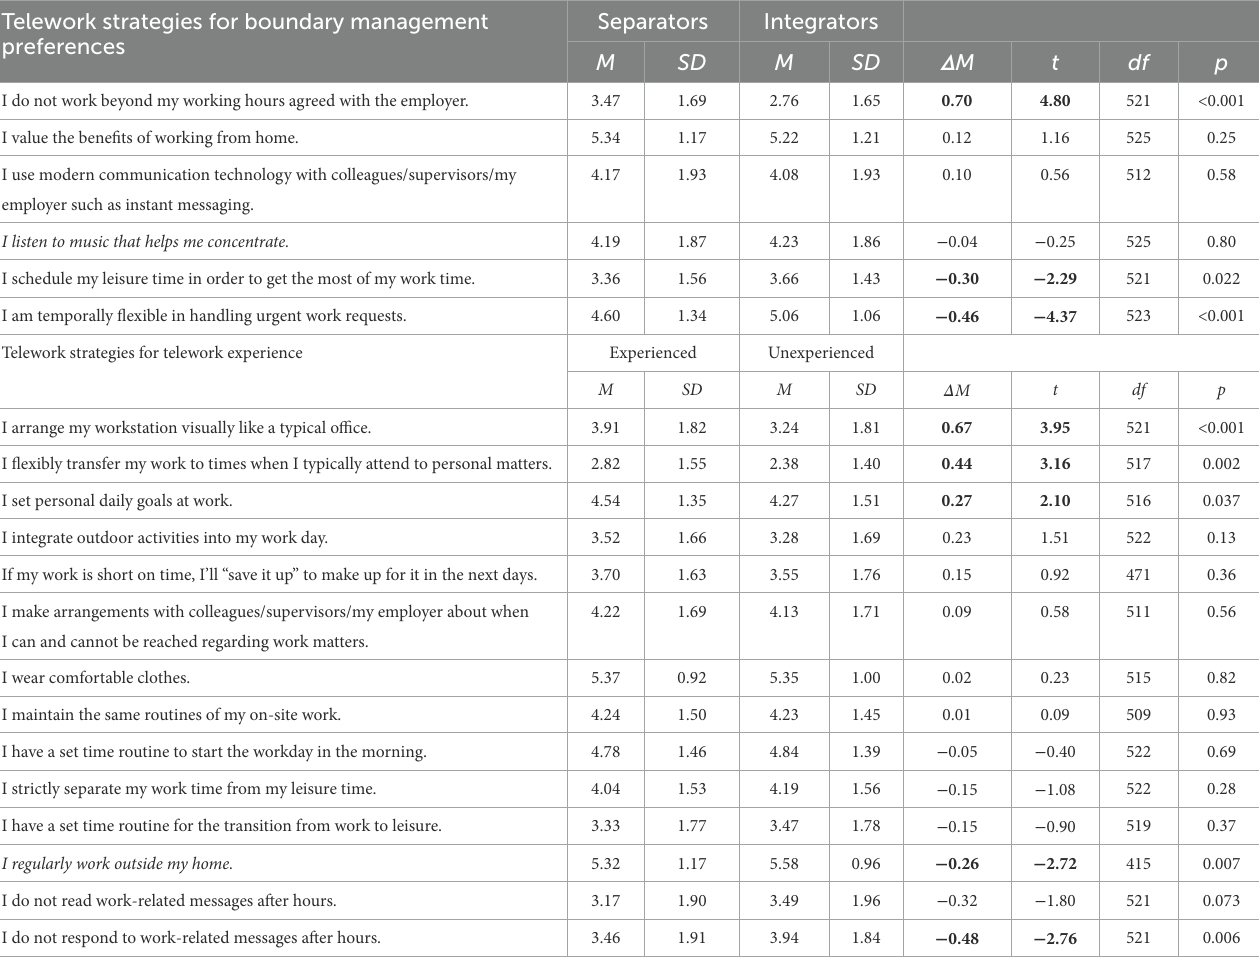
TABLE 2 Mean value differences of the implementation of telework strategies with significant interaction effects on job performance for boundary management preferences and telework experience. Telework strategies for boundary management